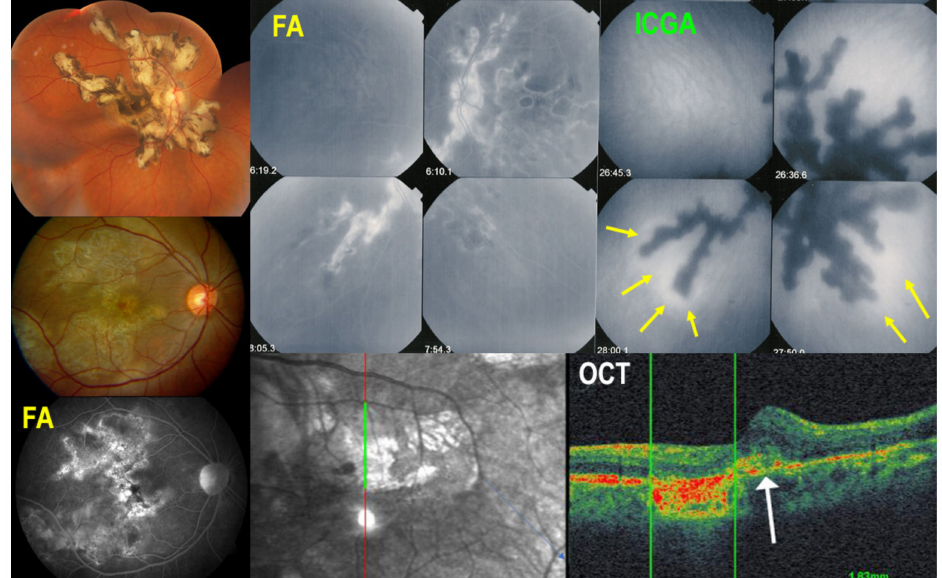
Figure 4. Multimodal imaging signs in SC. Typical fundus aspect of SC ( top left ); extensive central atrophy in a different case ( middle left ) with FA hyperfluorescent window effect ( bottom left ). Comparison of FA ( top middle ) and ICGA ( top right ) findings; ICGA hypofluorescence is much more widespread than FA hyperfluorescence, as it represents both atrophy and choriocapillaris non-perfusion of new lesions. Perilesional ICGA hyperfluorescent halo (yellow arrows) indicates progression of disease. OCT ( bottom right ) shows that at the border of atrophy, there is retinal oedema and damage to the outer retina (white